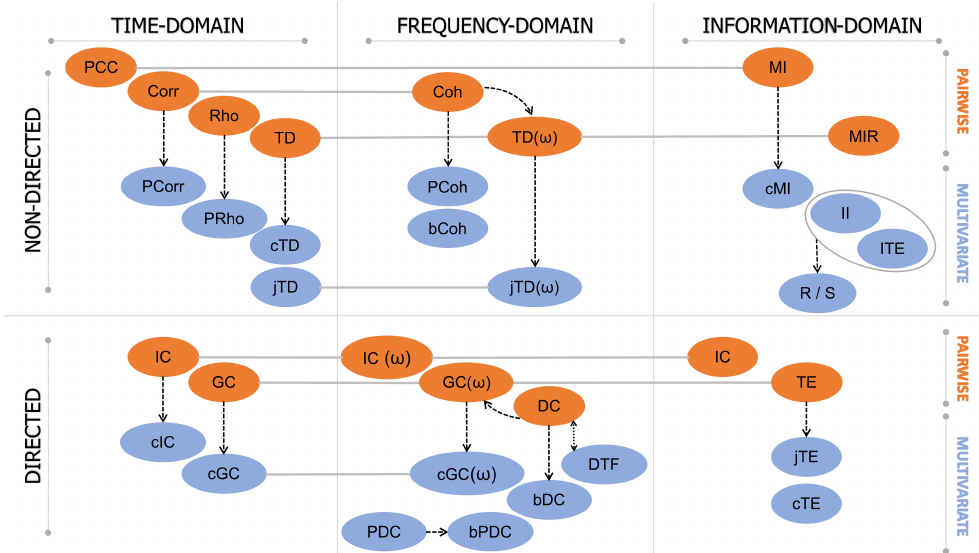
Figure 1. A schematic diagram of time-domain ( left ), frequency-domain ( middle ), and information- domain ( right ) measures of FC, divided into non-directed ( top row) and directed ( bottom row) approaches, and into pairwise (orange blocks) and multivariate (light blue blocks) methods. Con- tinuous gray lines represent connections between domains (i.e., time, frequency, and information domain). Dashed black arrows represent connections between methods (i.e., pairwise and mul- tivariate methods). The mathematical relation between DC and DTF is represented by a dotted bidirectional arrow. The gray ellipse surrounding the two blocks, II and ITE, reflects the equivalence of their mathematical